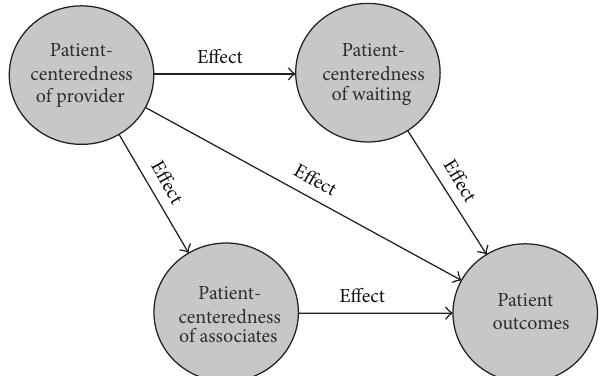
Figure 1: Primary Provider Theory. (Adapted from Aragon [19, 21, 23].)